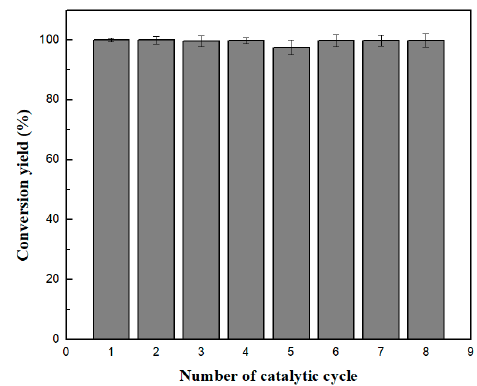
Figure 6. Operational stability of GO / Fe 2 O 3 -Mn 3 (PO 4 ) 2 CaLB-HNFs after eight reaction cycles for the enzymatic transesterification of tyrosol with vinyl butyrate in tert -butyl-methylether. Each reaction was carried out for 72 h at 50 °C.